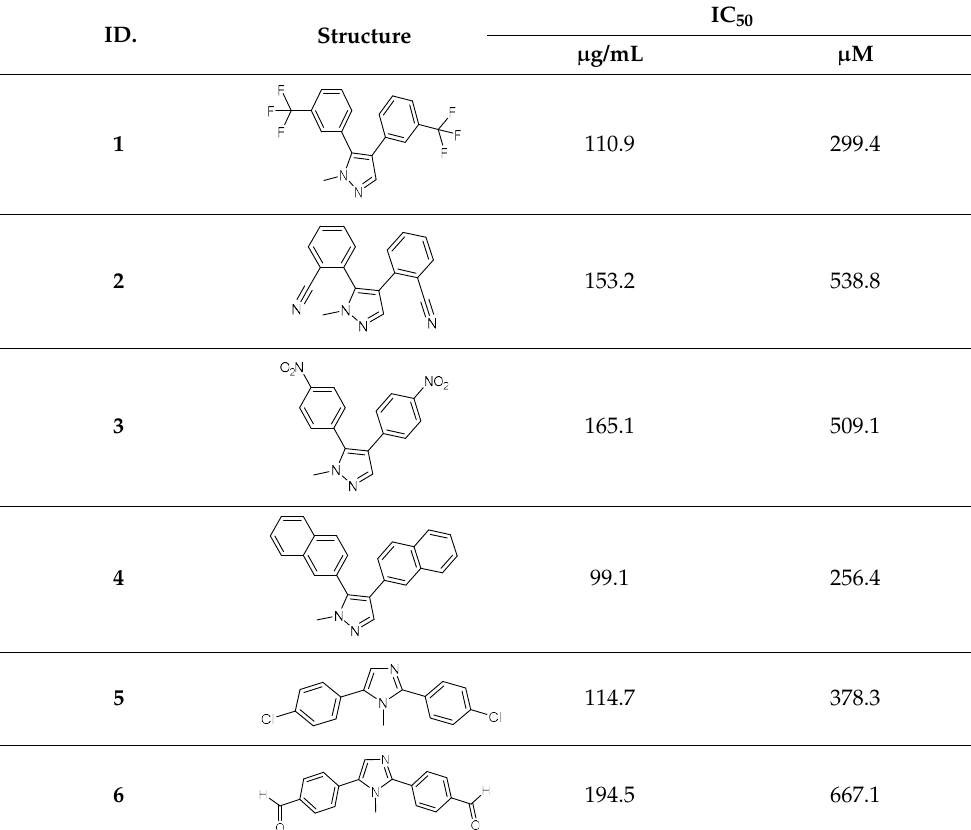
Table 1. IC 50 values of the tested pyrazole- and imidazole-based derivatives tested against F.o.a. ID.